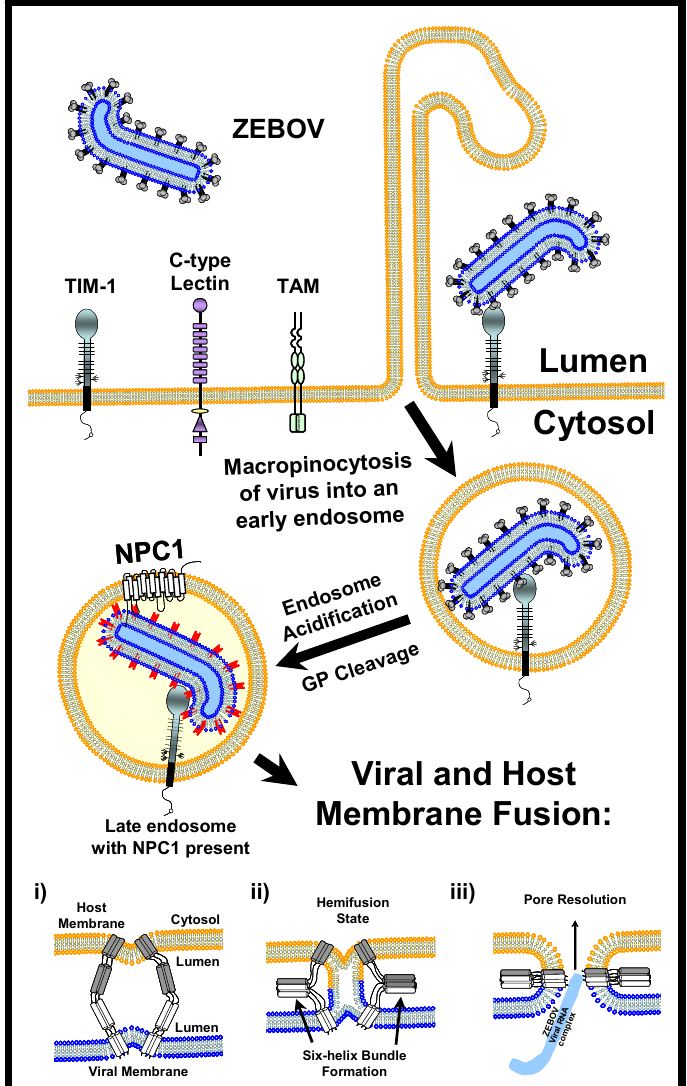
Figure 2. Model for filoviral entry. Trimers of filoviral GPs on virions interact with both attachment factors (C-type lectins) and receptors (TIM-1) on the surface of permissive cells. Attachment factors are likely to concentrate virions on cells before receptor engagement and virion internalization by macropinocytosis. Macropinocytosis is enhanced by tyrosine kinase receptors such as TAM family members. Following endosomal acidification, Cathepsins L and B trim the EBOV GP to a smaller form that needs at least one as yet undetermined factor to elicit GP fusion with host endosomal membranes. This smaller form of GP is able to interact with both TIM-1 and the endosomal portion of the NPC1 protein; however, whether GP and TIM-1 interact within endosomes is not known. The energetically unfavorable insertion of the EBOV GP fusion loop into host endosomal 2 membranes ( i ) is followed by the energetically favorable collapse of EBOV GP into a six-helix bundle ( ii ) allowing for lipid mixing and hemifusion of host and viral membrane lipids (ii). Finally, the hemifused host and viral membranes resolve and a complete pore is formed ( iii ) through which the viral genomic complex passes into the cytoplasm, allowing the viral replication cycle to